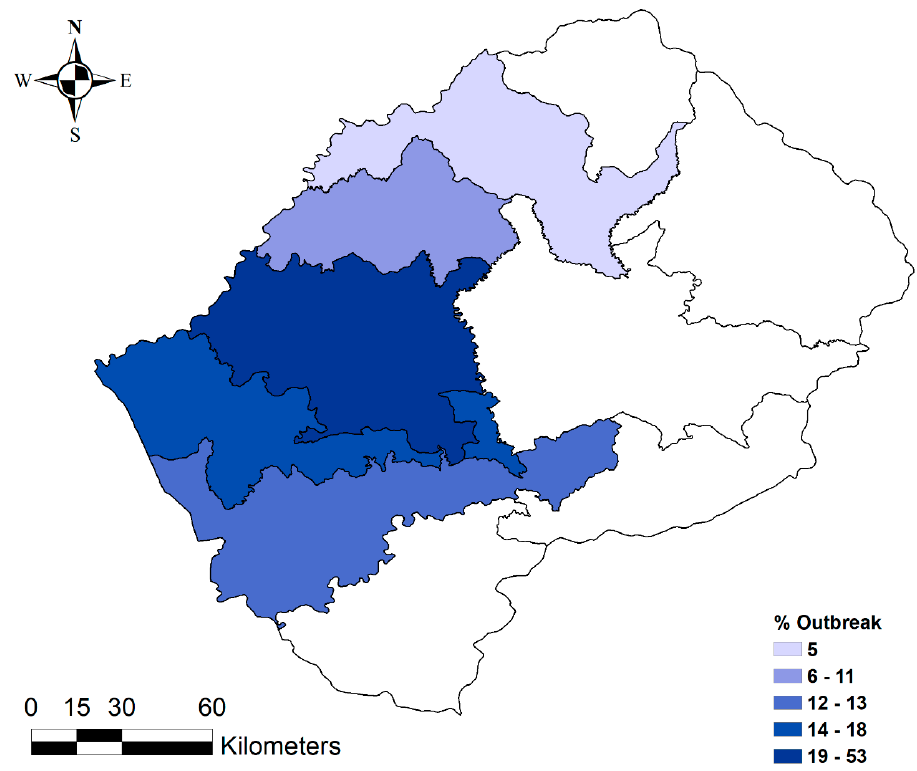
Figure 3. Distribution of anthrax outbreaks in the ten (n = 10) districts of Lesotho from 2005 to 2016. Int. J. Environ. Res. Public Health 2020 , 17 , x